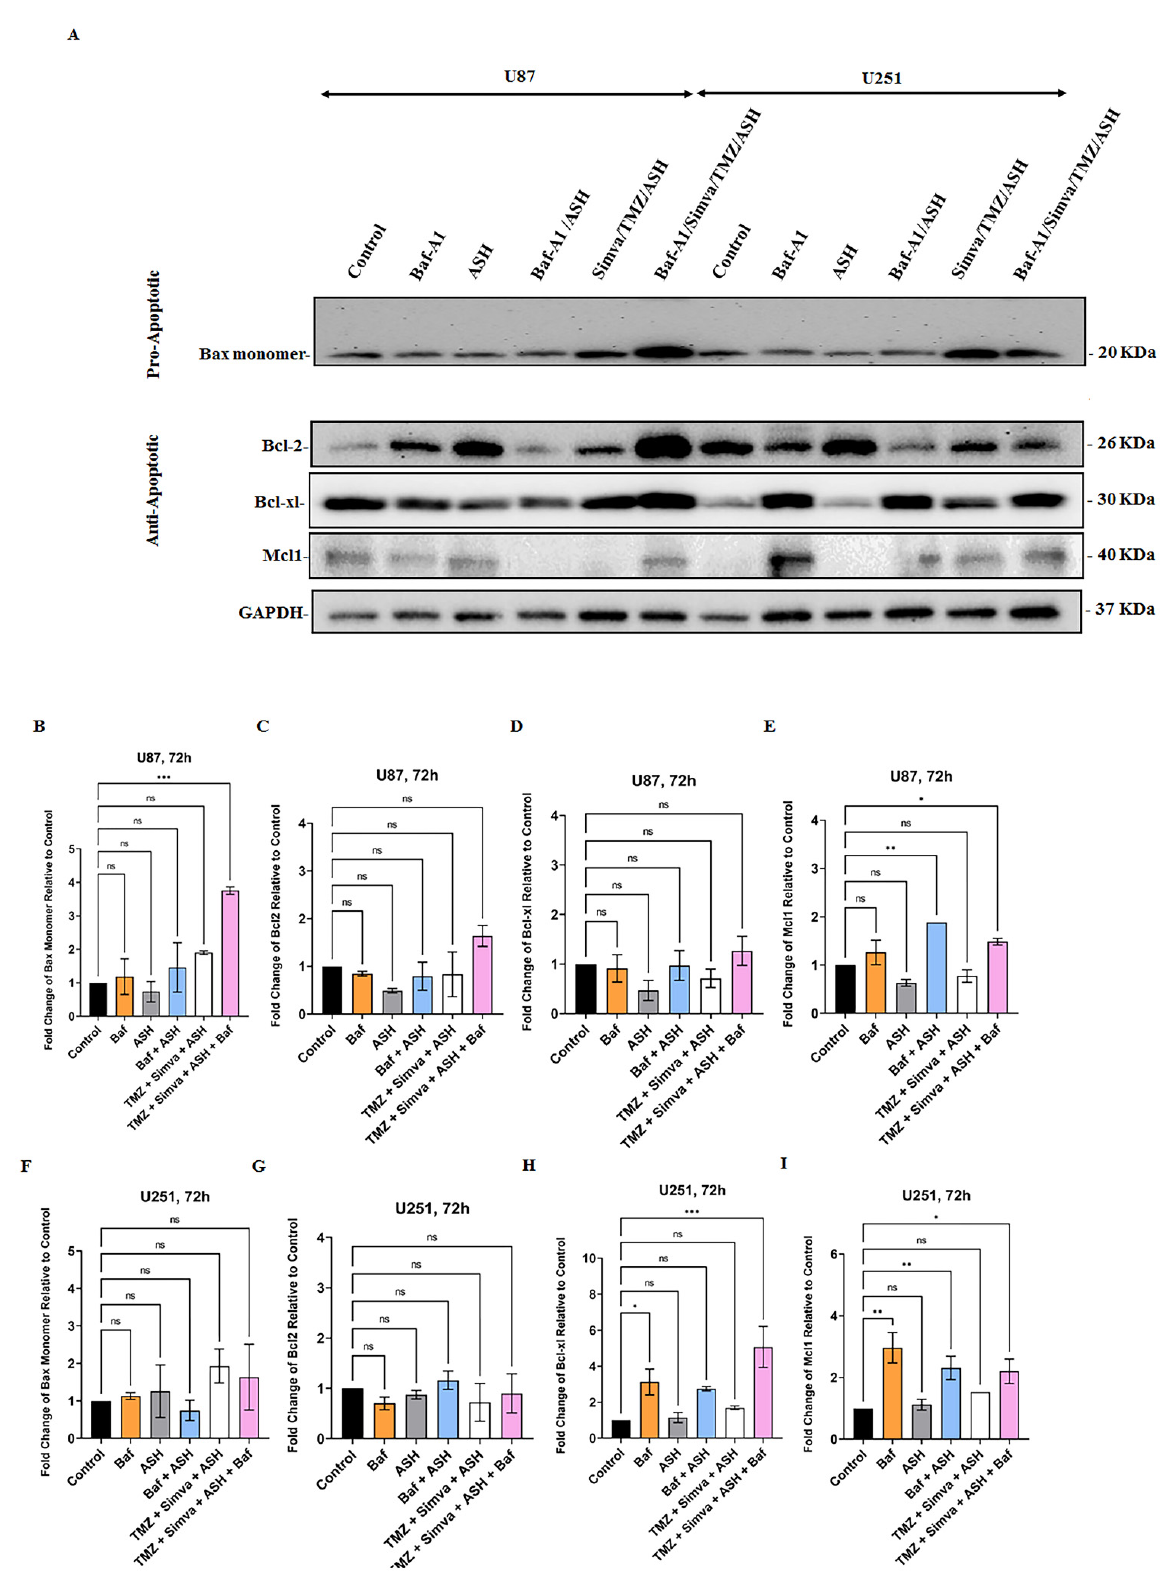
Figure 6. Effect of Autophagy Flux inhibition on pro and anti- apoptotic proteins expressions in GBM cells. We used Bafilomycin A1 (Baf) 5 nM in combination with ASH 1.5 µ M and TMZ/Simva/ASH (Simva 1 µ M, U251 and Simva 2.5 µ M, U87). We evaluated pro- (Bax) and anti- apoptotic Bcl2